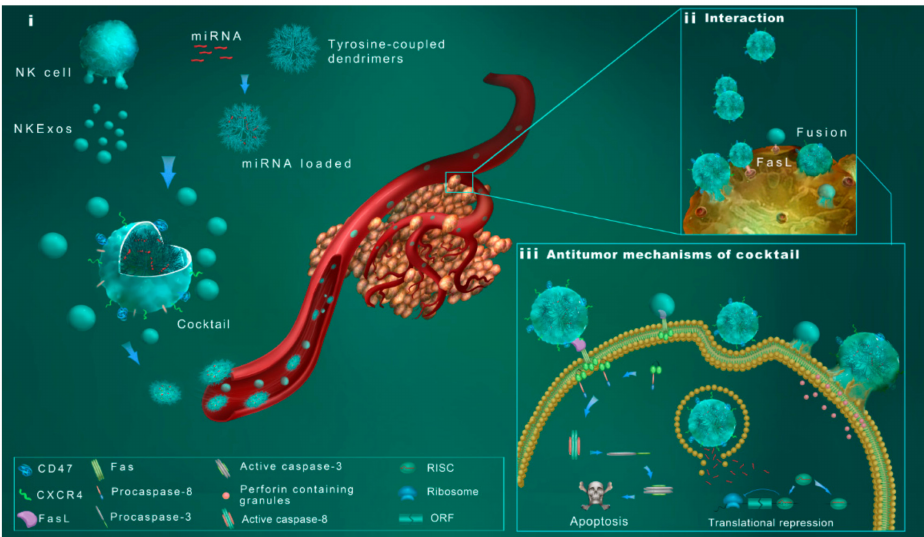
Figure 5. Schematic design of the NN / NKEXO cocktail for tumor targeting and drug delivery. ( i ) Main components of the cocktail: exosomes derived from NK cells (NKEXOs); exosome camouflaged